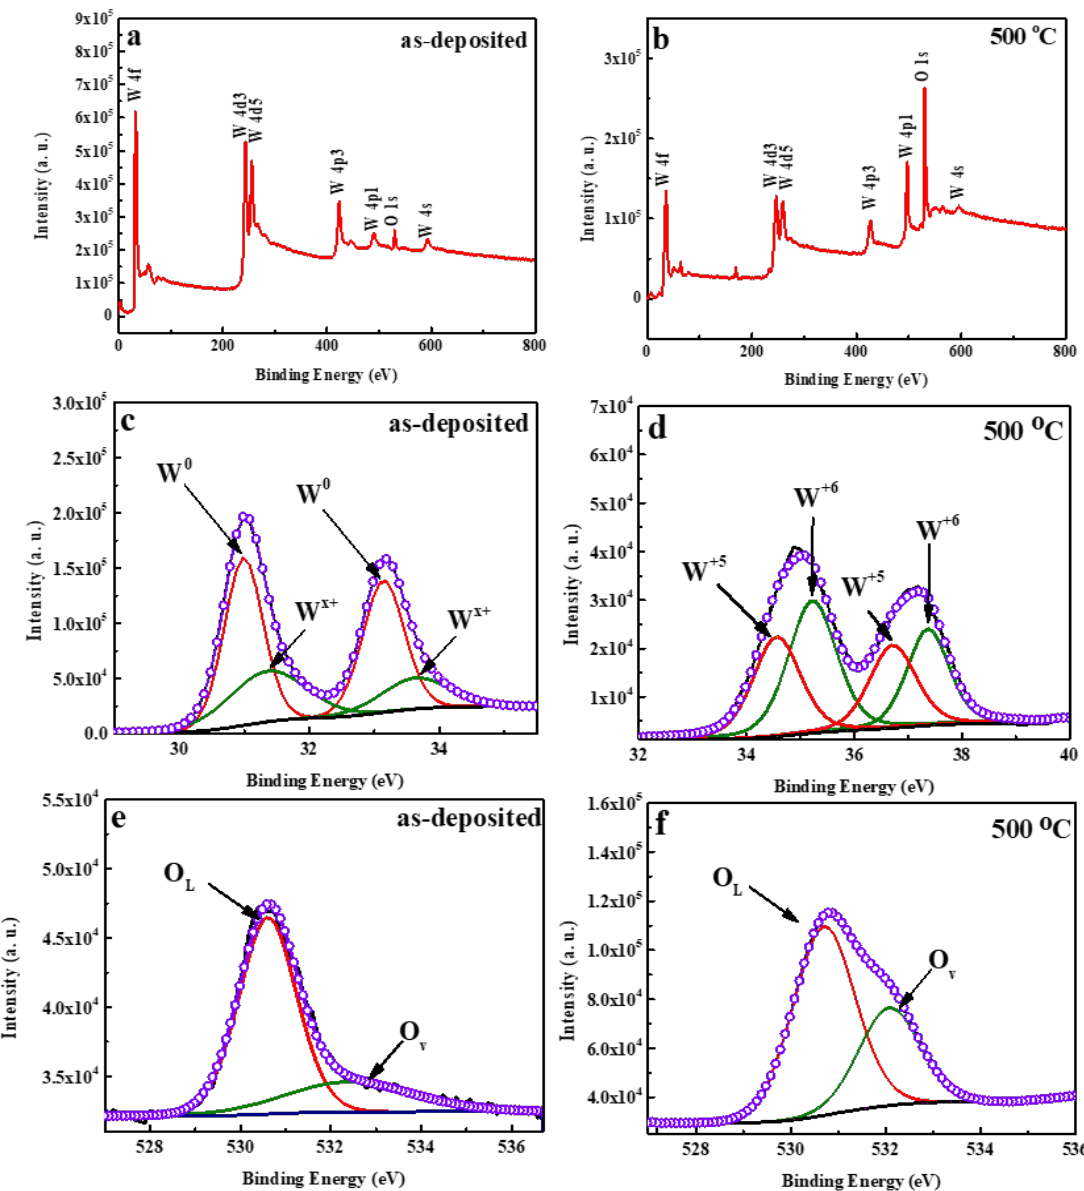
Figure 5. X-ray photo-electron spectroscopy (XPS) spectra of ( a , b ) the survey spectra, ( c , d ) W4f, and ( e,f ) O1s of the as-deposited W film and W 18 O 49 film fabricated at 500 °C, respectively. The PEC performance of the fabricated W 18 O 49 photo-anode films was evaluated in 0.1 M of Na 2 SO 4 electrolyte under the illumination of a 300 W Xenon lamp. Figure 6a shows the photo-current density generated by W 18 O 49 films prepared at different deposition time at a bias 0.6 V. Under dark conditions, these samples did not produce any noticeable current. In the presence of light, photo-current was measured to be 0.10, 0.25, 0.60, and 0.62 mA/cm 2 for W 18 O 49 films deposited for 1, 5, 10, and 20 min, respectively. The weak photo-current recorded in the presence of W 18 O 49 thin films deposited 1 and 2 min could be ascribed to the discontinuity of the film’s layer as indicated by